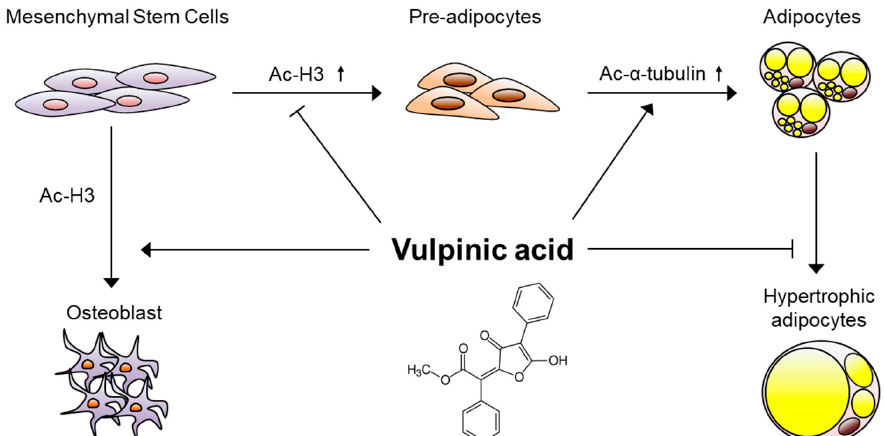
Figure 6. Molecular model underlying the mechanism of actions of vulpinic acid. During the early stage of mesenchymal stem cells, vulpinic acid promotes osteogenic commitment while preventing adipogenic commitment via H3 acetylation-mediated gene modulations. During terminal differentiation to mature adipocytes from preadipocytes, vulpinic acid enhances de novo generation of adipocytes via acetylation of α -tubulin, reducing hypertrophic adipocytes.